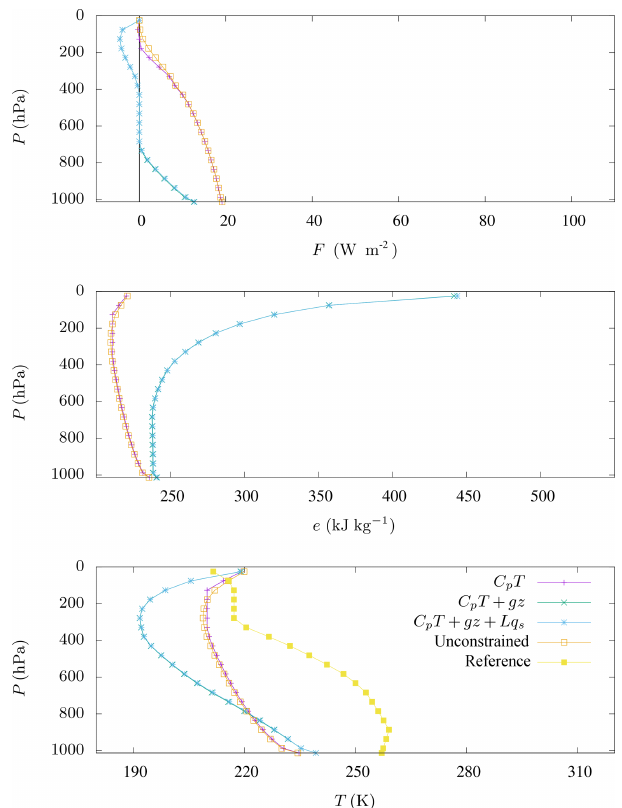
Figure 4. Energy flux F , specific energy e , and temperature T for sub-arctic winter atmospheric composition measured by Mc- Clatchey et al. (1972) and different expressions for energy on the constraint ( e = C p T , e = C p T + gz , and e = C p T + gz + Lq s ). The elevation is given in pressure level P . Results for the unconstrained model of Herbert et al. (2013) are represented. We also give the tem- perature profile corresponding to the measurements of McClatchey et al. (1972), labelled as “reference” for qualitative